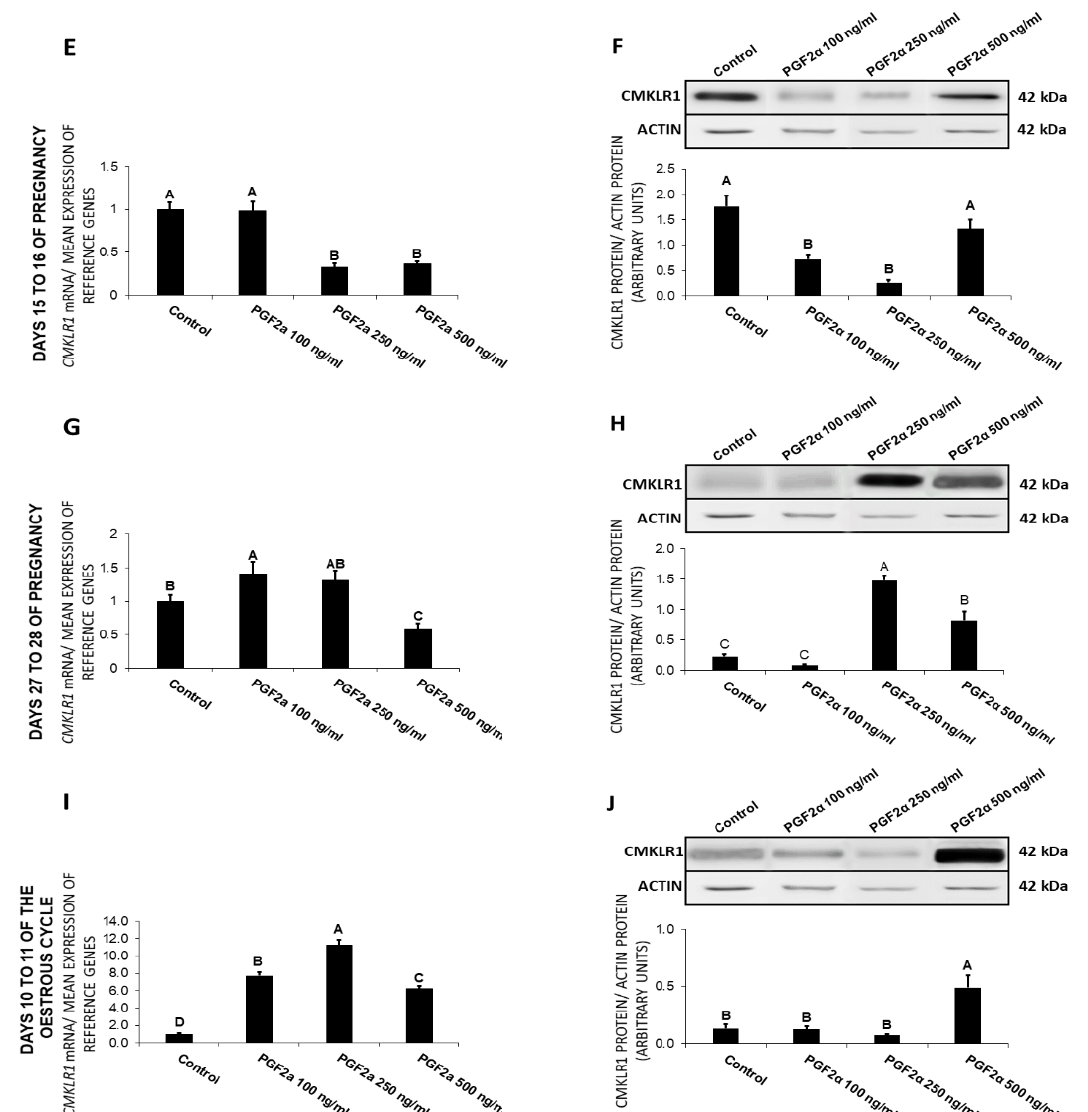
Figure 6. The influence of prostaglandin F 2 α (PGF 2 α ; 100, 250, 500 ng / mL) on chemokine-like receptor 1 (CMKLR1) mRNA ( A , C , E , G , I ) and protein ( B , D , F , H , J ) expression in the porcine endometrium on days 10 to 11, 12 to 13, 15 to 16, and 27 to 28 of the pregnancy, and on days 10 to 11 of the estrous cycle. The gene expression was determined by quantitative real-time PCR. The protein concentration was determined by the western blotting analysis; upper panels: Representative immunoblots; lower panels: Densitometric analysis of CMKLR1 protein relative to actin protein. Results are reported as the means ± S.E.M. ( n = 5). Bars with di ff erent superscripts di ff er ( p <